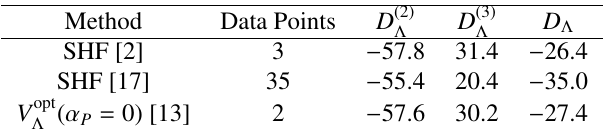
Table 2. Λ -nuclear potential depths (in MeV) from two SHF calculations fitting B Λ data points, and from